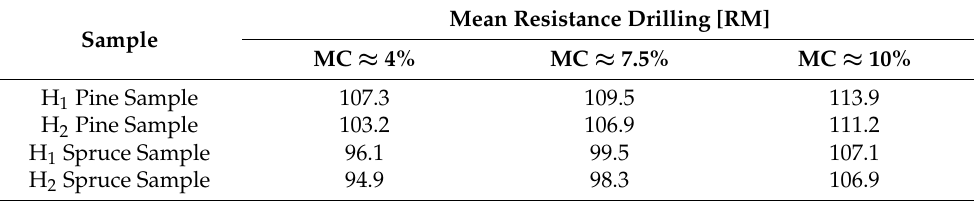
Table 4. Summary of the drilling resistance results for selected samples in the moisture range below the fibre saturation point